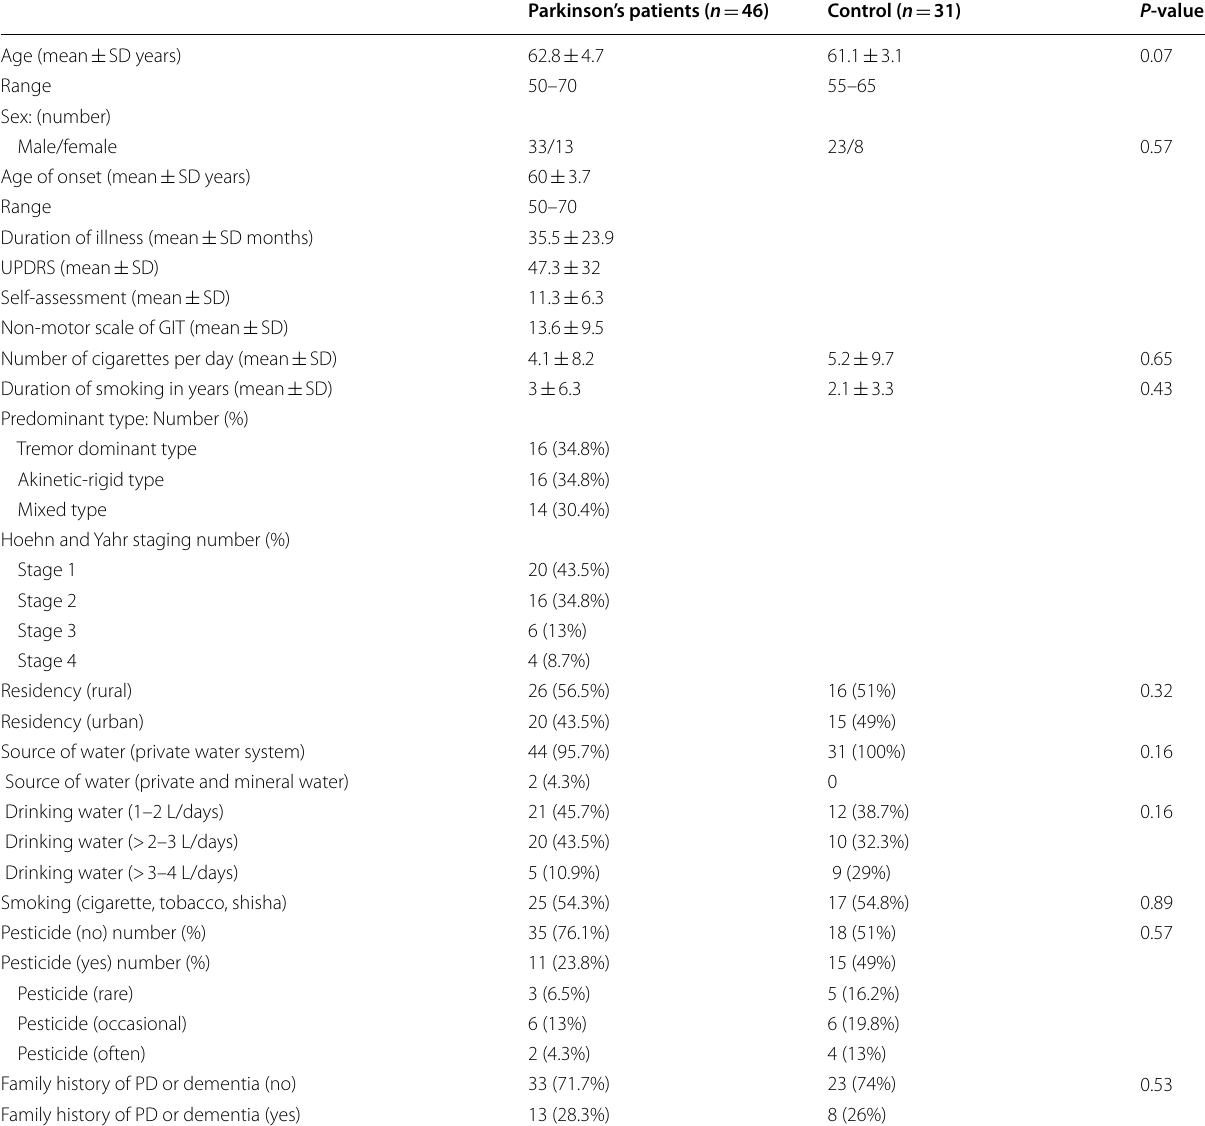
Table 1 Demographic and clinical characteristics of the studied groups